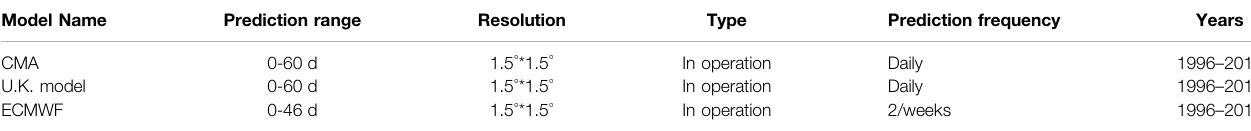
TABLE 1 | CMA, U.K., and ECMWF model prediction data